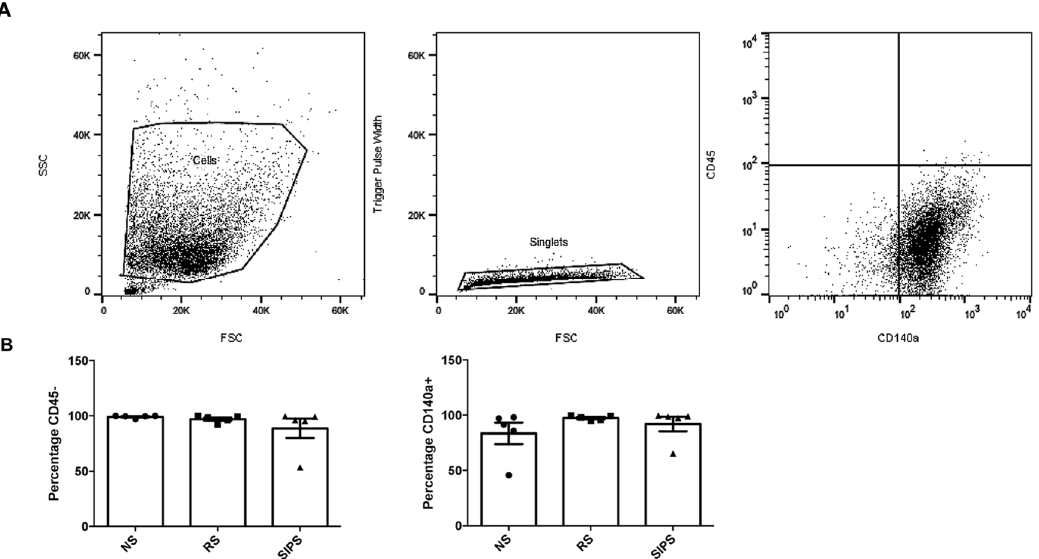
Figure 3. Surface immunophenotyping of fibroblasts by flow cytometry. ( A ). Gating strategy for fibroblasts of NS, RS, and SIPS. Selection of the cells on SSC vs. FSC density plot (Step 1). Single-cell selection and aggregates exclusion (Step 2). Hematopoietic cells CD45+ exclusion, and fibroblast CD140a+ selection (Step 3). ( B ). Percentage of CD45- and CD140a+ expression in NS (black circle), RS (black square), and SIPS (black triangle). No significant difference was observed between groups. Each bar represents the mean ± SEM of CD45- and CD140a+ cells. Five independent experiments were performed (Kruskal–Wallis-Dunn’s test).